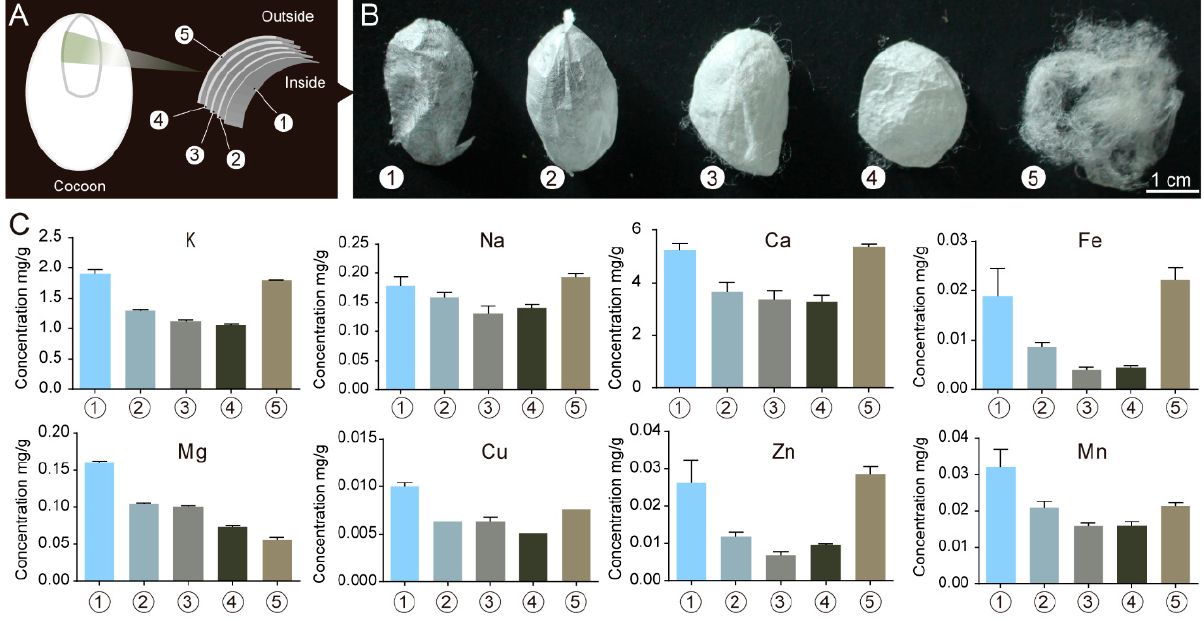
Figure 4. Content of metal elements in different cocoon layers of silkworm cocoons. (A) Schematic diagram of cocoon layers; (B) Photographs of different cocoon layers; (C) Contents of different metal elements in different cocoon layers. 1–5: From inside to outside, different cocoon layers, Error bars show SD.